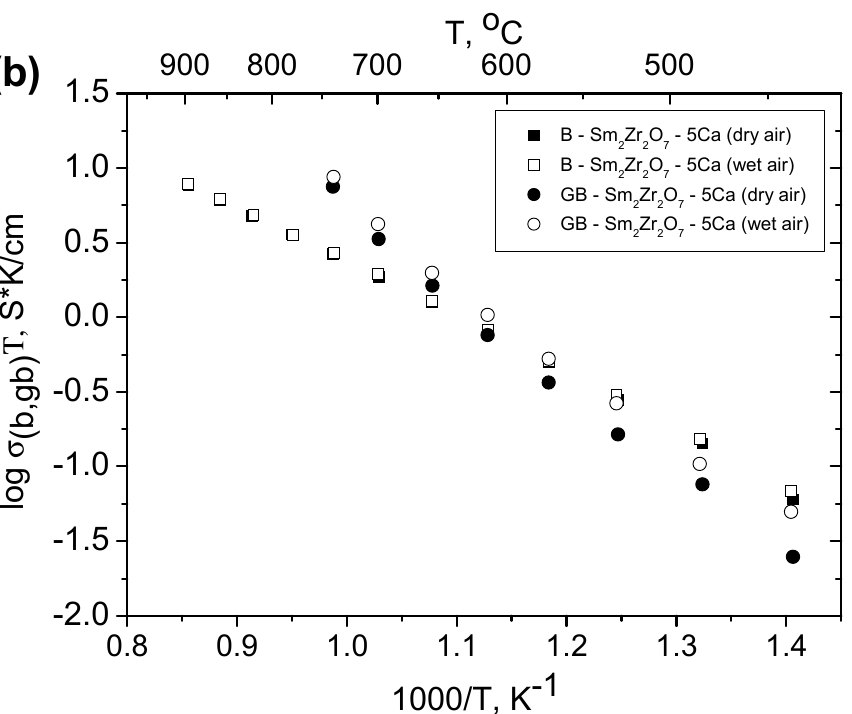
Figure 7. Bulk and grain-boundary conductivities of ( a ) Sm 2 − x Ca x Zr 2 O 7 − x/2 (x = 0, 0.05) and ( b ) Sm 2 − x Ca x Zr 2 O 7 − x/2 (x = 0, 0.1) in dry and wet air.